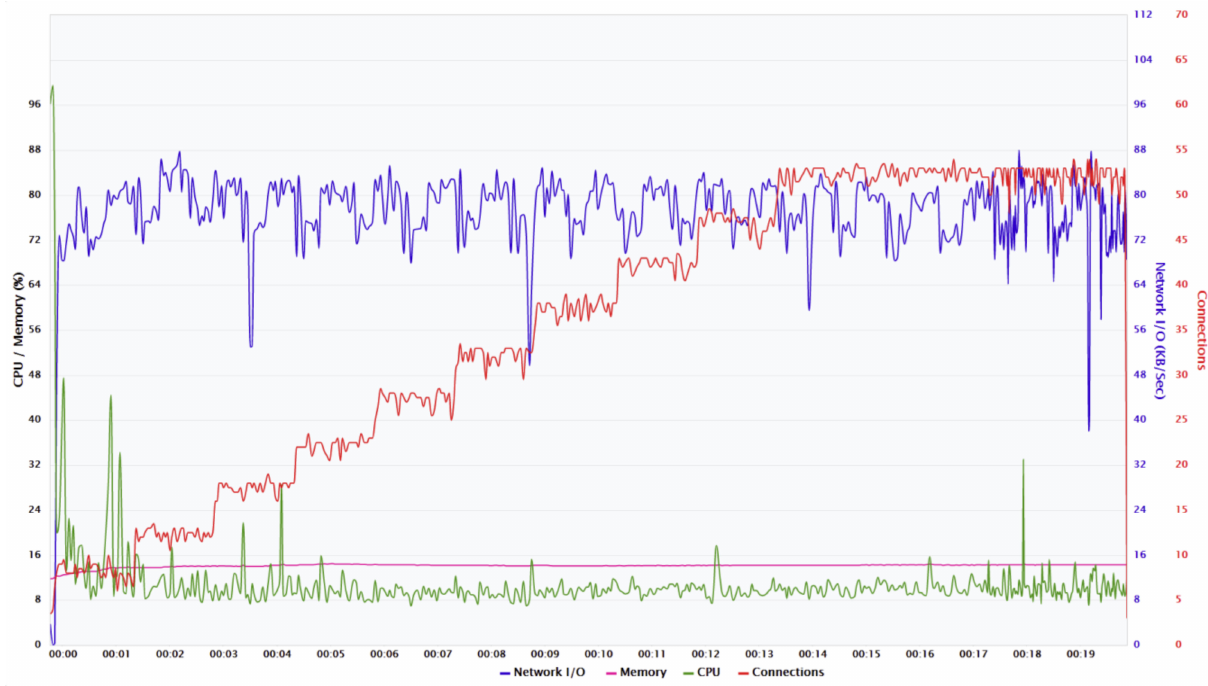
Figure 7. Engine Health Report SPIDEP-MSA-K8s-T2. The colored lines represent various parameters as follows: the blue line is the bandwidth traffic; the purple line is the memory load generated by the users; the green line is the CPU load generated by the users; and the red line is the active connections within the